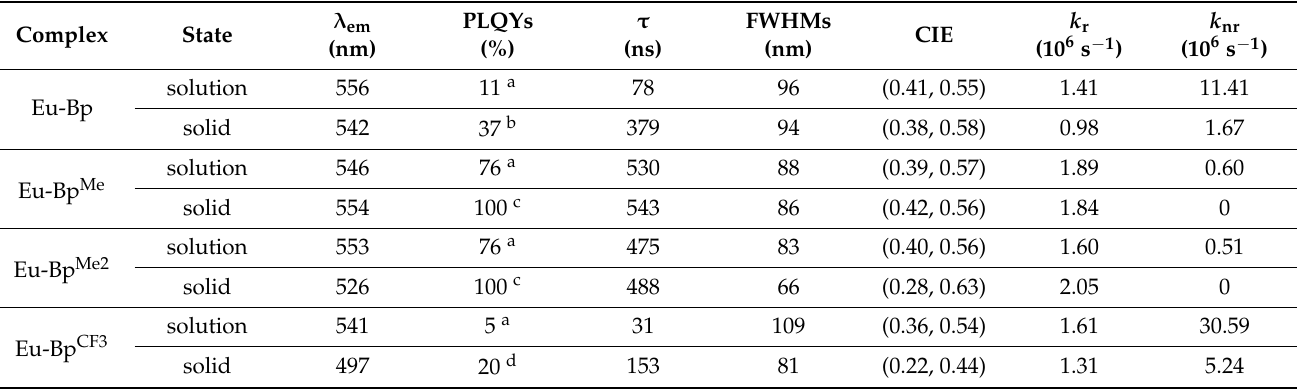
The transient photoluminescence decay curves of the four Eu(II) complexes in tetrahy- drofuran solution (1 × 10 − 3 M) and as solid powder are shown in Figure 3c,d,